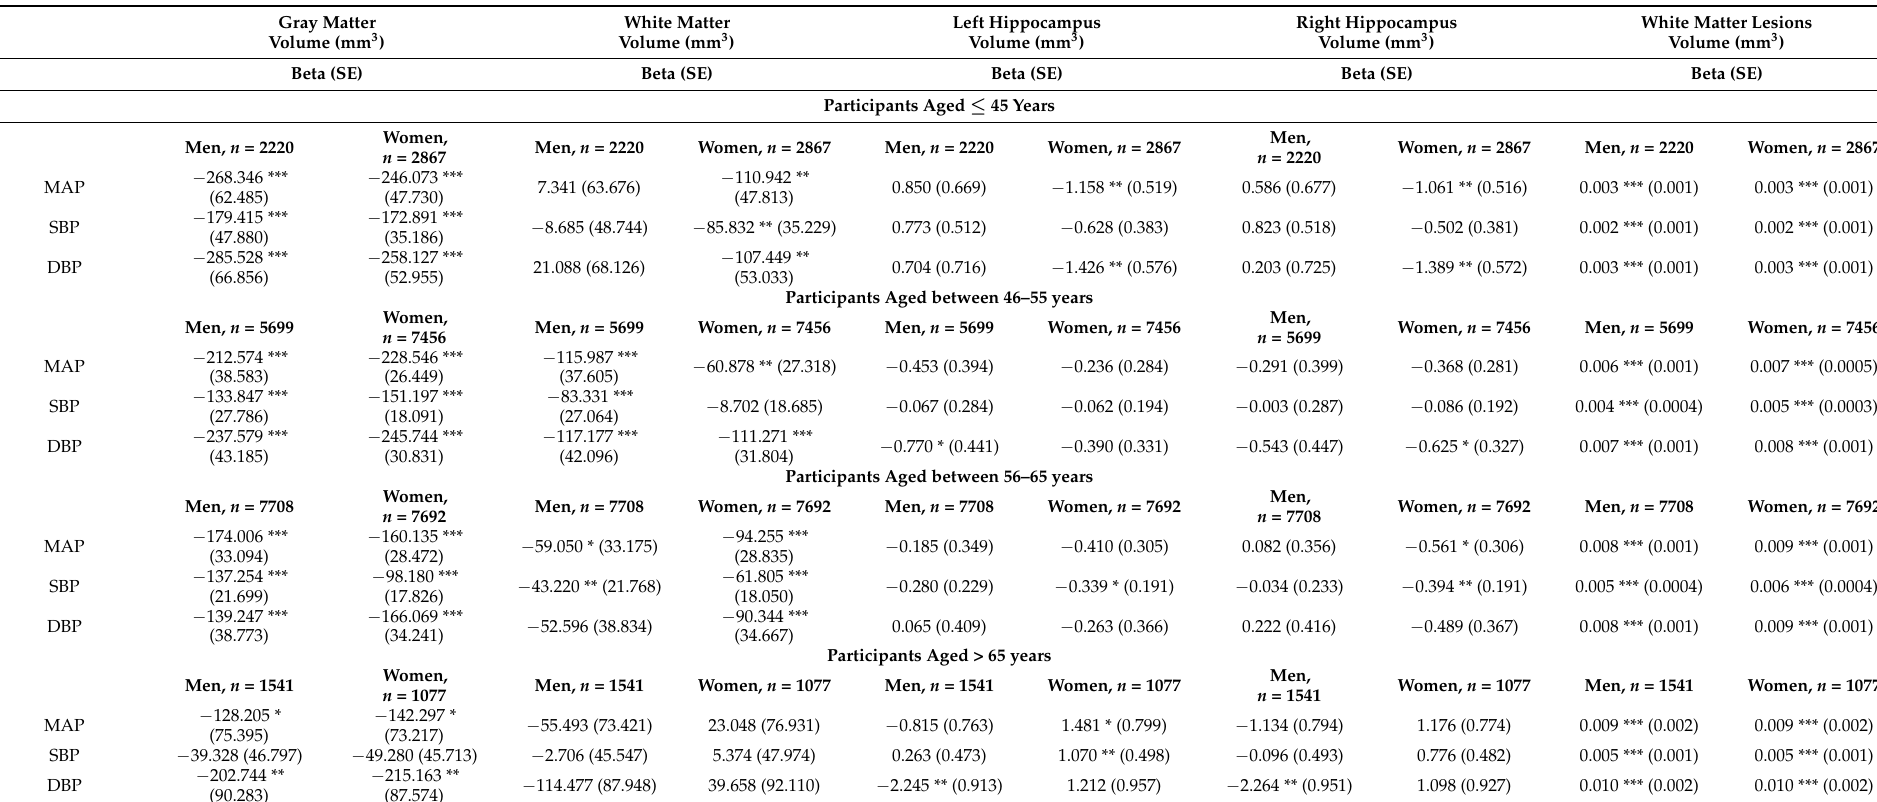
Table 2. Association between baseline BP including MAP, SBP, and DBP and brain volumes across age groups in men and women at UK biobank